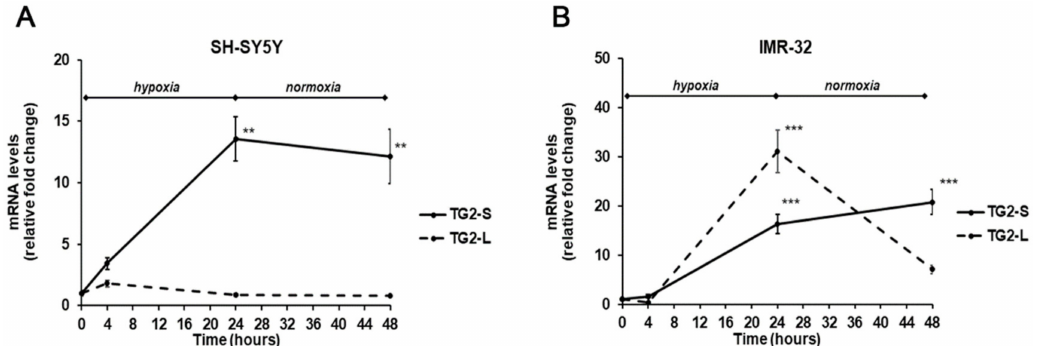
Figure 3. Di ff erential expression of TG2-L and TG2-S transcripts in SH-SY5Y ( A ) and IMR-32 ( B ) NB cells after exposure to hypoxic conditions (1% O 2 ) up to 24 h followed by reoxygenation for further 24 h. After incubation times, cells were harvested and the mRNA levels were evaluated by Real-Time PCR. Data are expressed as mean ± SEM. ** p < 0.01 and *** p < 0.001 significant di ff erences in comparison to controls.